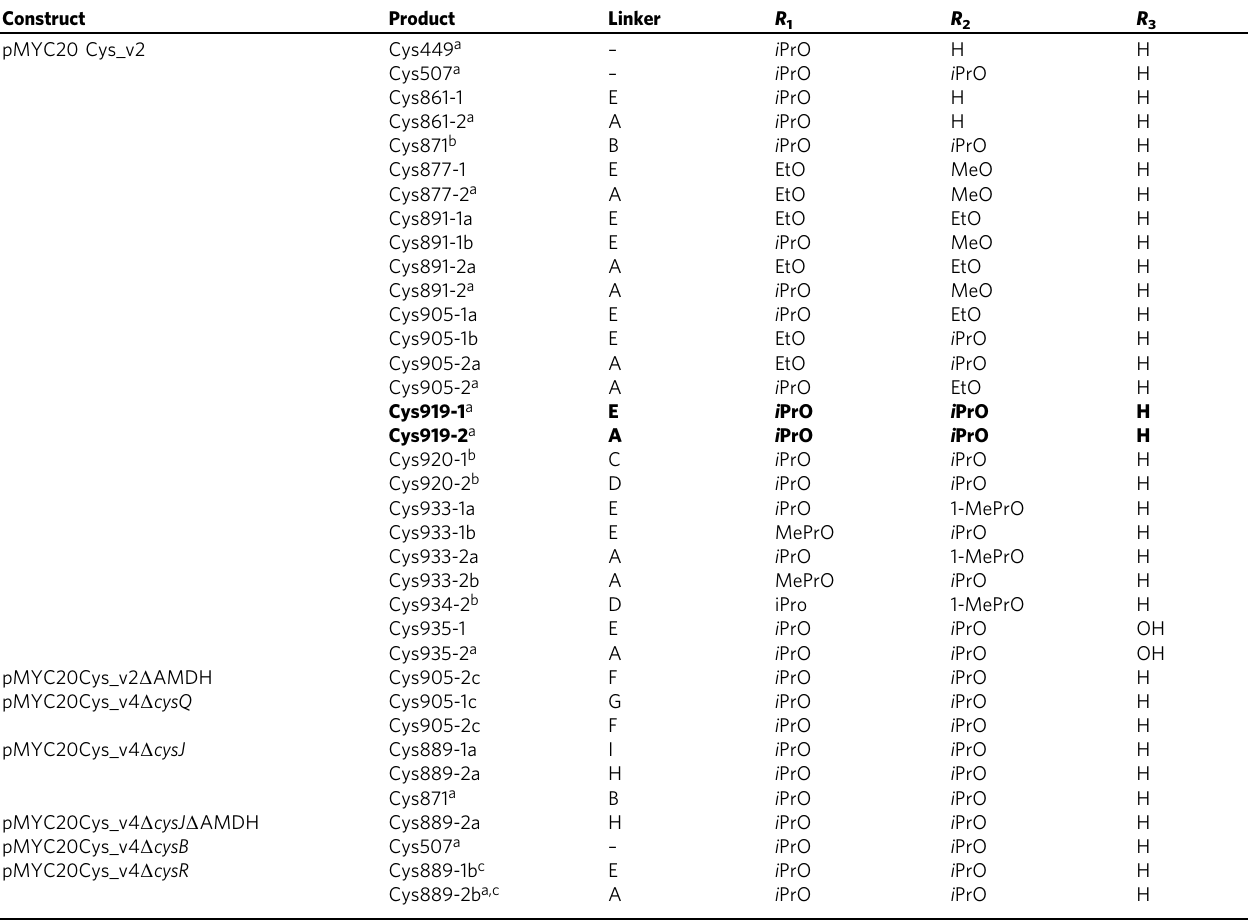
Linker and R 1 , R 2 , R 3 labeling was adapted from Fig. 1. pMYC20Cys_v2 includes all genes from the cystobactamid BGC described by Baumann et al. 1 . Derivatives in bold are major products in native producer strains and the heterologous producer. For deletion constructs, only major products, which are relevant for the elucidation of the linker biosynthesis, are shown. a Heterologously produced derivatives that were described previously. b Known derivatives that were not identi fi ed in the heterologous producer. c Cys889-1b and Cys889-2b (reported as Coralmycin D) 25 carry an N-terminal amine rather than a